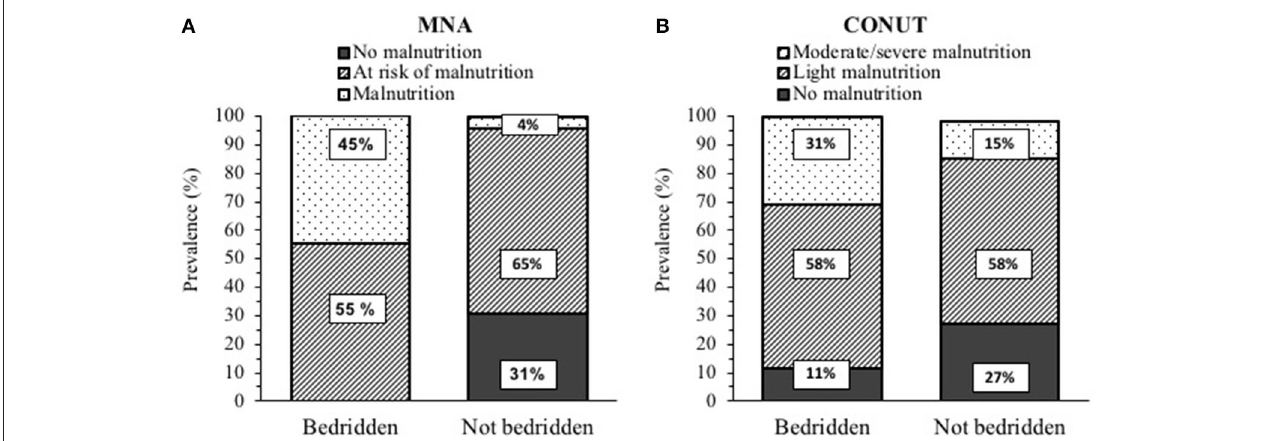
FIGURE 3 | Prevalence of malnutrition in post-acute COVID-19 patients (53 bedridden and 91 not bedridden) according to: (A) Mini Nutritional Assessment (MNA). and (B) Controlling nutritional status (CONUT). The p < 0.01 for differences in frequencies between the bedridden and not bedridden patients for both MNA and